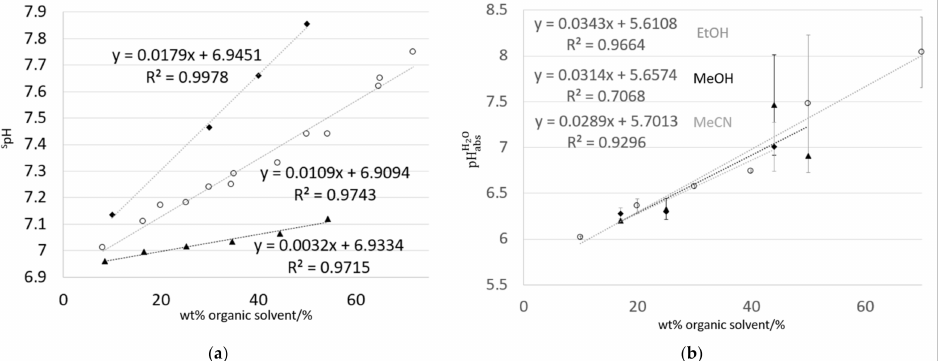
Figure 4. Between >0 wt% and ď 70 wt% organic solvent: ( a ) Literature s pH values for mixtures of water with ethanol ( ) [41], methanol ( (cid:78) ) [39], and acetonitrile ( (cid:117) ) [44], and ( b ) pH H 2 O (cid:35) is chosen based on data available from the water–organic mixtures studied here: 10 wt%–70 wt% ethanol, 17 wt%–50 wt% methanol, and 17 wt%–44 wt% acetonitrile. Error bars are calculated using Equation (1), and represent the distribution of values measured at different institutes.